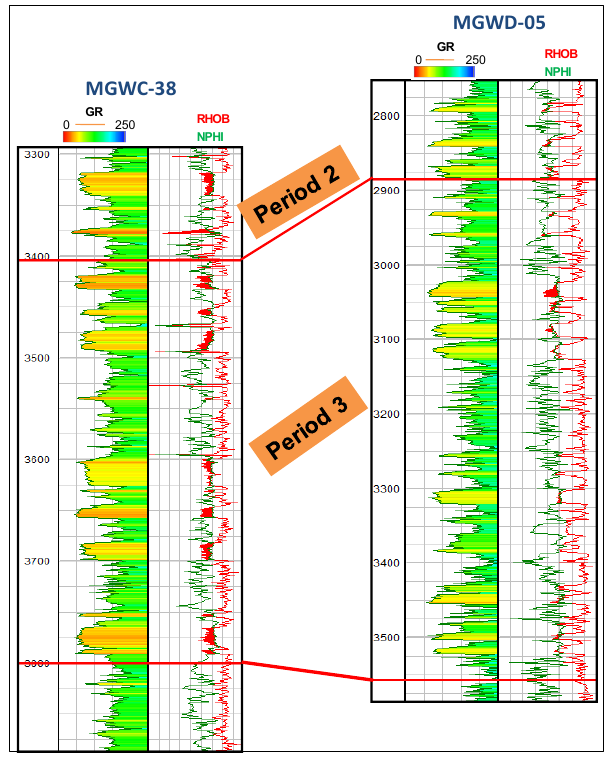
Figure 13: Wire line character of depositional sequences of period 3